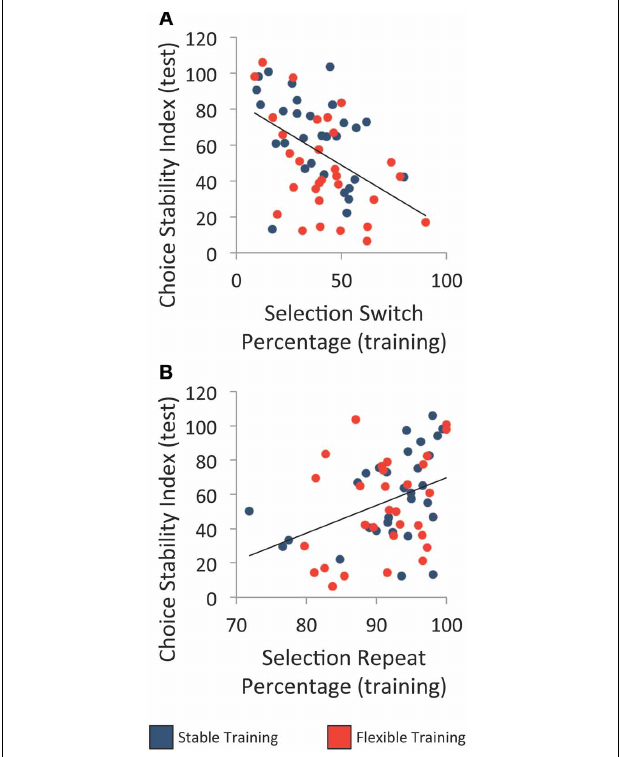
FIGURE 6 | Comparison of individuals’ performance during training and test. (A) Relationship between the percentage of object selection switches following an unrewarded selection during training and choice stability index at test. (B) Relationship between the percentage of object selection repeats following a rewarded selection during training and choice stability index at test. Each line denotes the best-fit linear regression equation when collapsing across training